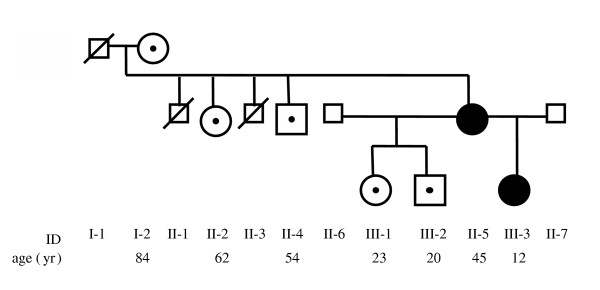
A Canadian multigenerational FPLD3 kindred. Darkened symbols indicate affected individuals, each of whom was later confirmed to be heterozygous for the respective PPARG nonsense mutation. Dots inside white symbols indicate normal PPARG genotype. Subject identification number and age in years are shown below the appropriate symbols.